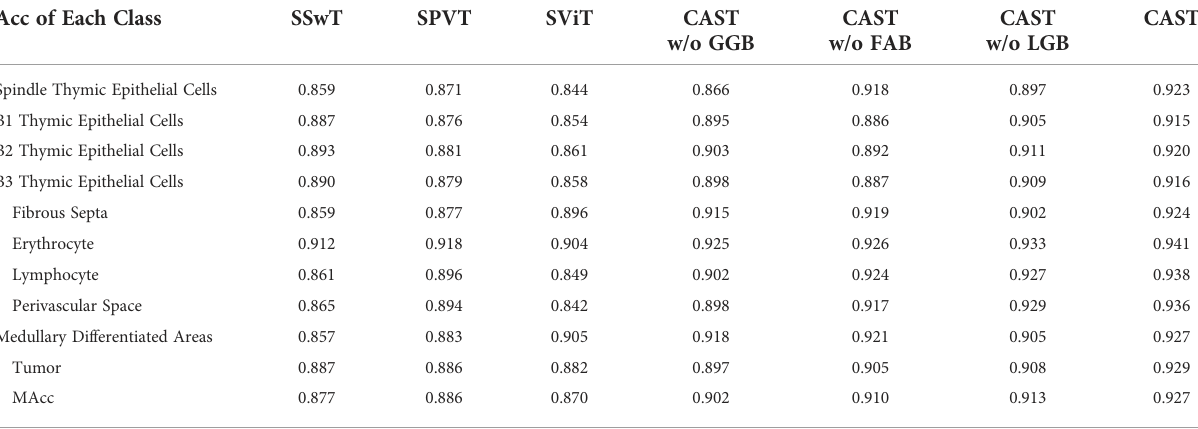
TABLE 6 Ablation study (Acc and MAcc) for multiple paths in the proposed CAST on the THW dataset. Acc of Each Class